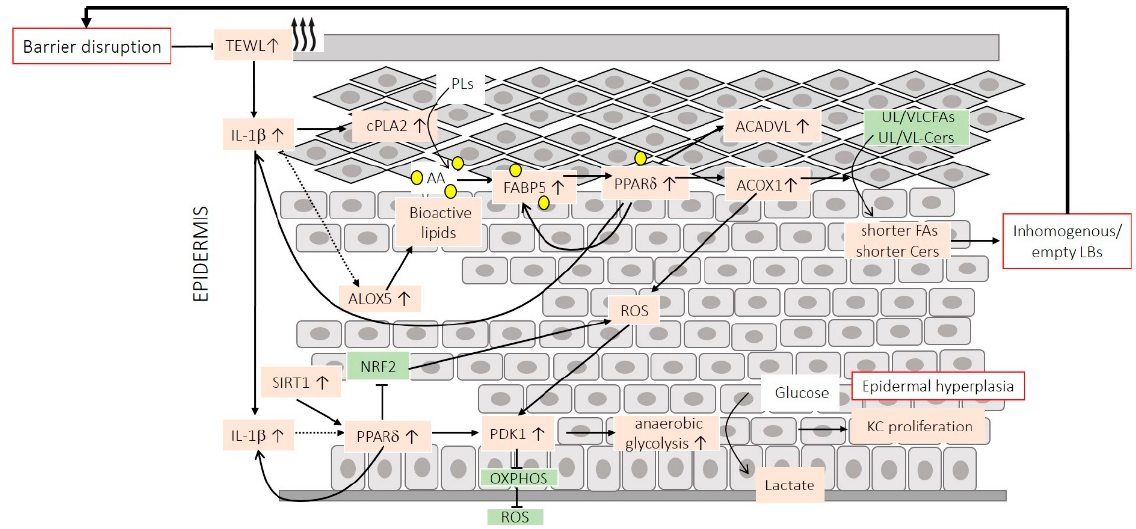
Figure 1. Potential role of PPAR δ in keratinocytes in lesional atopic dermatitis and psoriasis: Epidermal barrier impairment, likely originating from (epi)genetic abnormalities, enhances trans-epidermal water loss (TEWL) and the production of IL-1 β in granular keratinocytes (KCs), which upregulates cPLA 2 involved in the cleavage of membrane phospholipids (PLs) and the release of arachidonic acid (AA). AA and its metabolites, produced by oxidation via ALOX5 into bioactive lipids, are shuttled to the nucleus by FABP5 to activate PPAR δ , which, in turn, increases the expression of ACOX1 and ACADVL. Increased ACOX1 consumes ultra- and very-long-chain fatty acids (UL/VLCFAs) and ceramides (Cers), resulting in the improper embedding of stratum corneum lipids into lamellar bodies (LBs), which weakens the efficacy of the stratum corneum barrier, hence perpetuating epidermal barrier impairment. Overactivity of ACOX1 produces excessive hydrogen peroxide, which might signal within granular KCs as well as through all the epidermal layers to cause oxidative stress and metabolic changes. This might be amplified by the downregulation of NRF2 by endogenous ligand-bound PPAR δ . In the basal layers, IL-1 β , produced either locally or in granular KCs, and SIRT1, which is produced in the lower epidermis, contribute to the activation of PPAR δ via unidentified mechanisms. This results in the upregulation of PDK1 and the shift toward anaerobic glycolysis, which circumvents mitochondrial function, including the production of mitochondrial ROS. Anaerobic glycolysis sustains KC hyperproliferation via rapid ATP